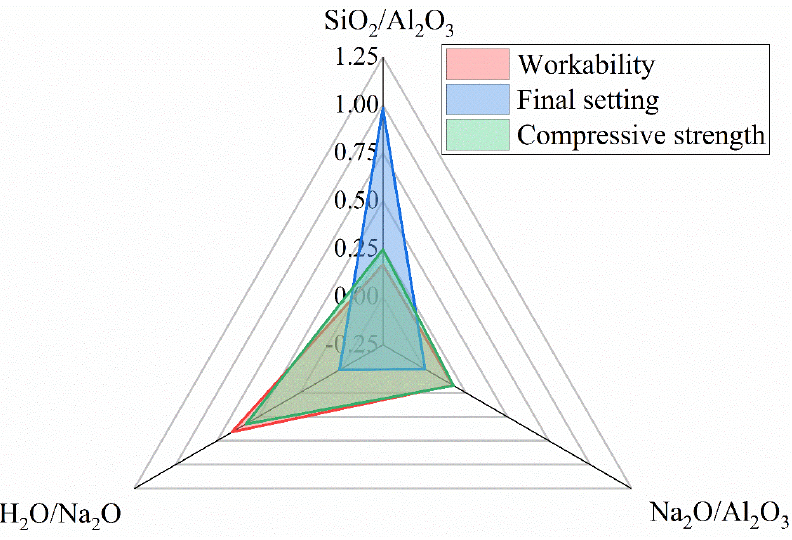
Figure 11. Sensitivities of workability, final set and compressive strength to compositional ratios.